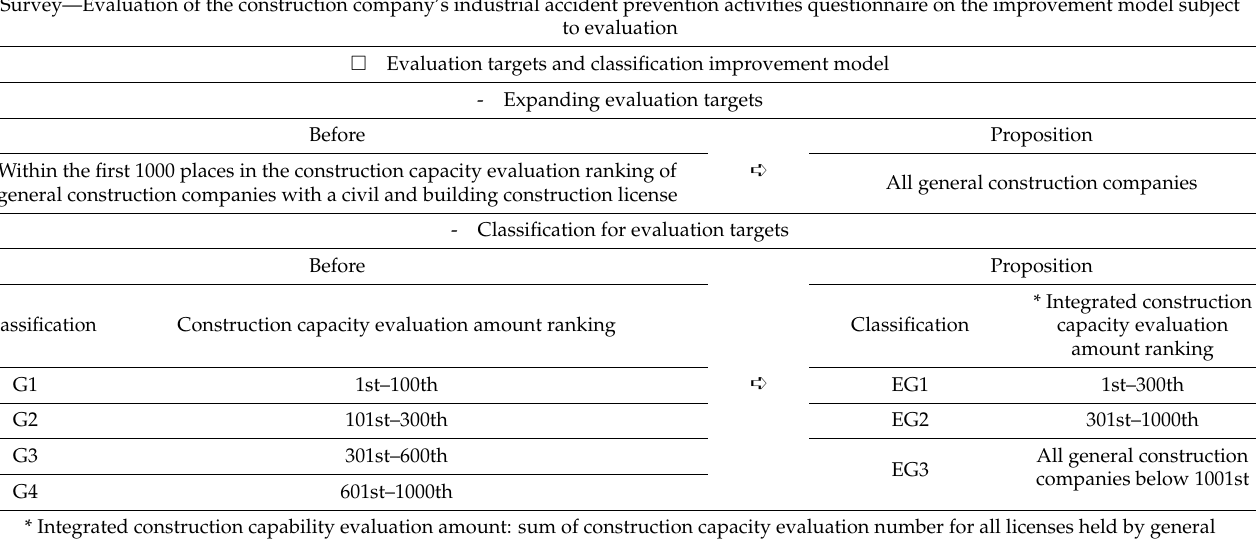
Table 17. Example of a survey on the improvement model for evaluation target.